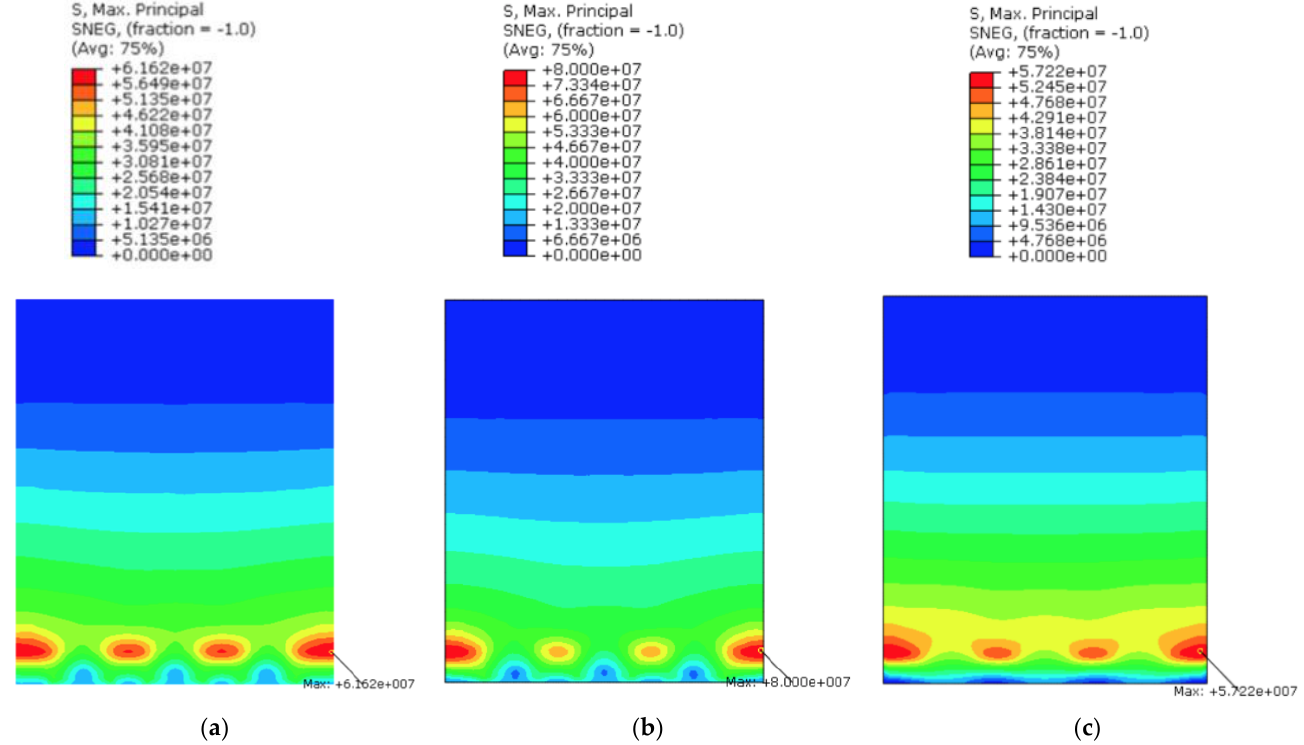
Figure 15. Numerical analysis of principal stress distribution and peaks in glass for the ( a ) Refined model, ( b ) SM1 simplified model, and ( c ) SM2 simplified model (ABAQUS) under double twin-tyre impact (300 mm being the drop height), with legend values in Pa.